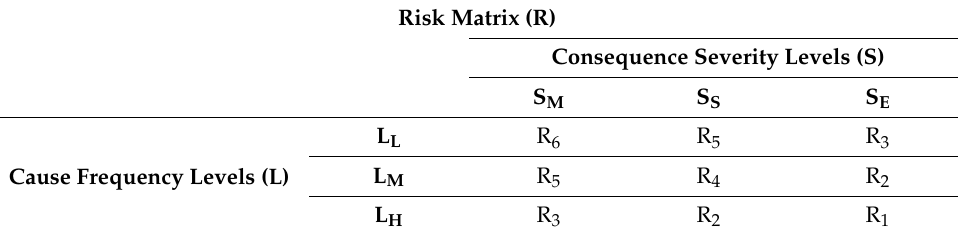
Table 1. Fundamental risk-ranking criteria by the IEC (2003)